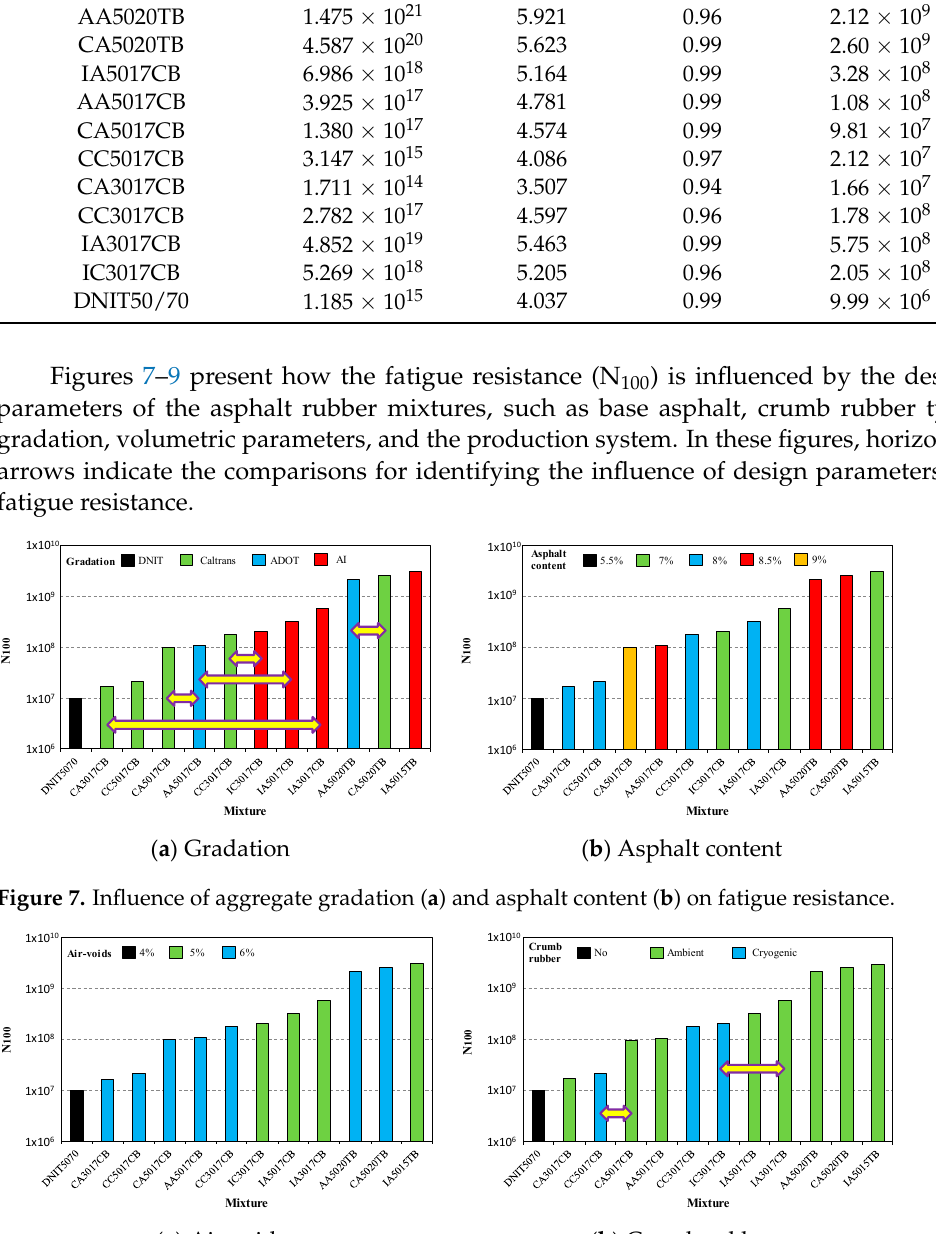
Table 10. Fatigue law parameters (20 ◦ C; 10 Hz).